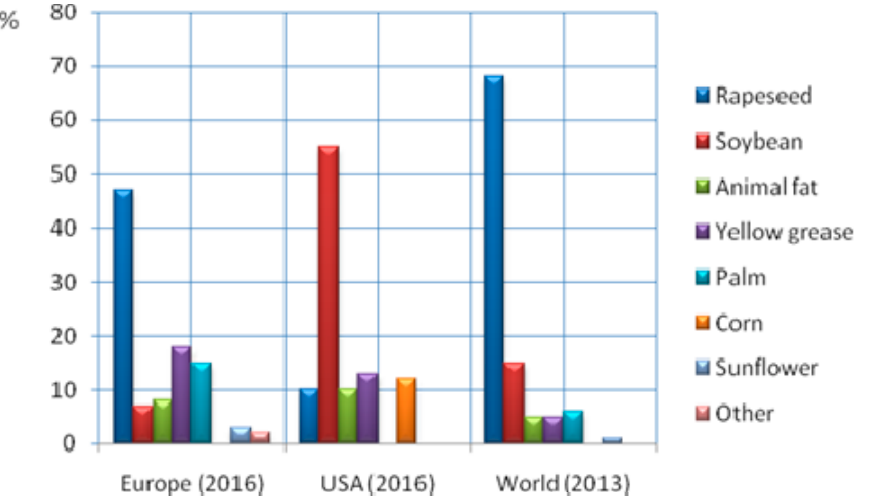
Figure 1. Feedstock inputs for biodiesel production in the European Union (2016), USA (2016) and the world (2013). Data from Ref. [29,30].